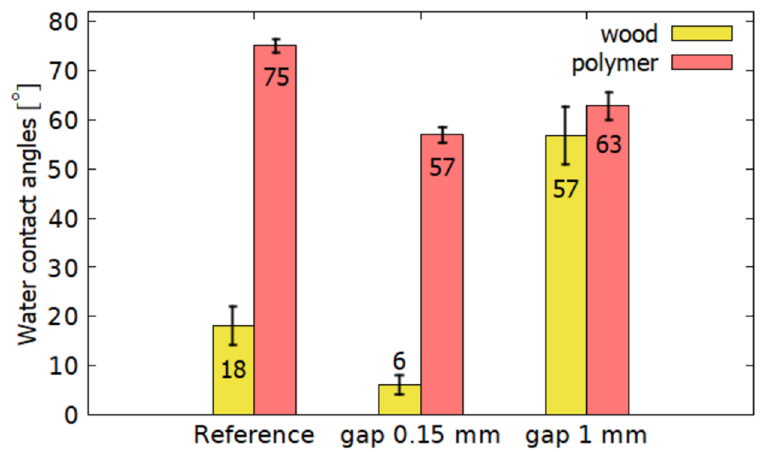
Figure 6. Comparison of water contact angles between polymer and wood.